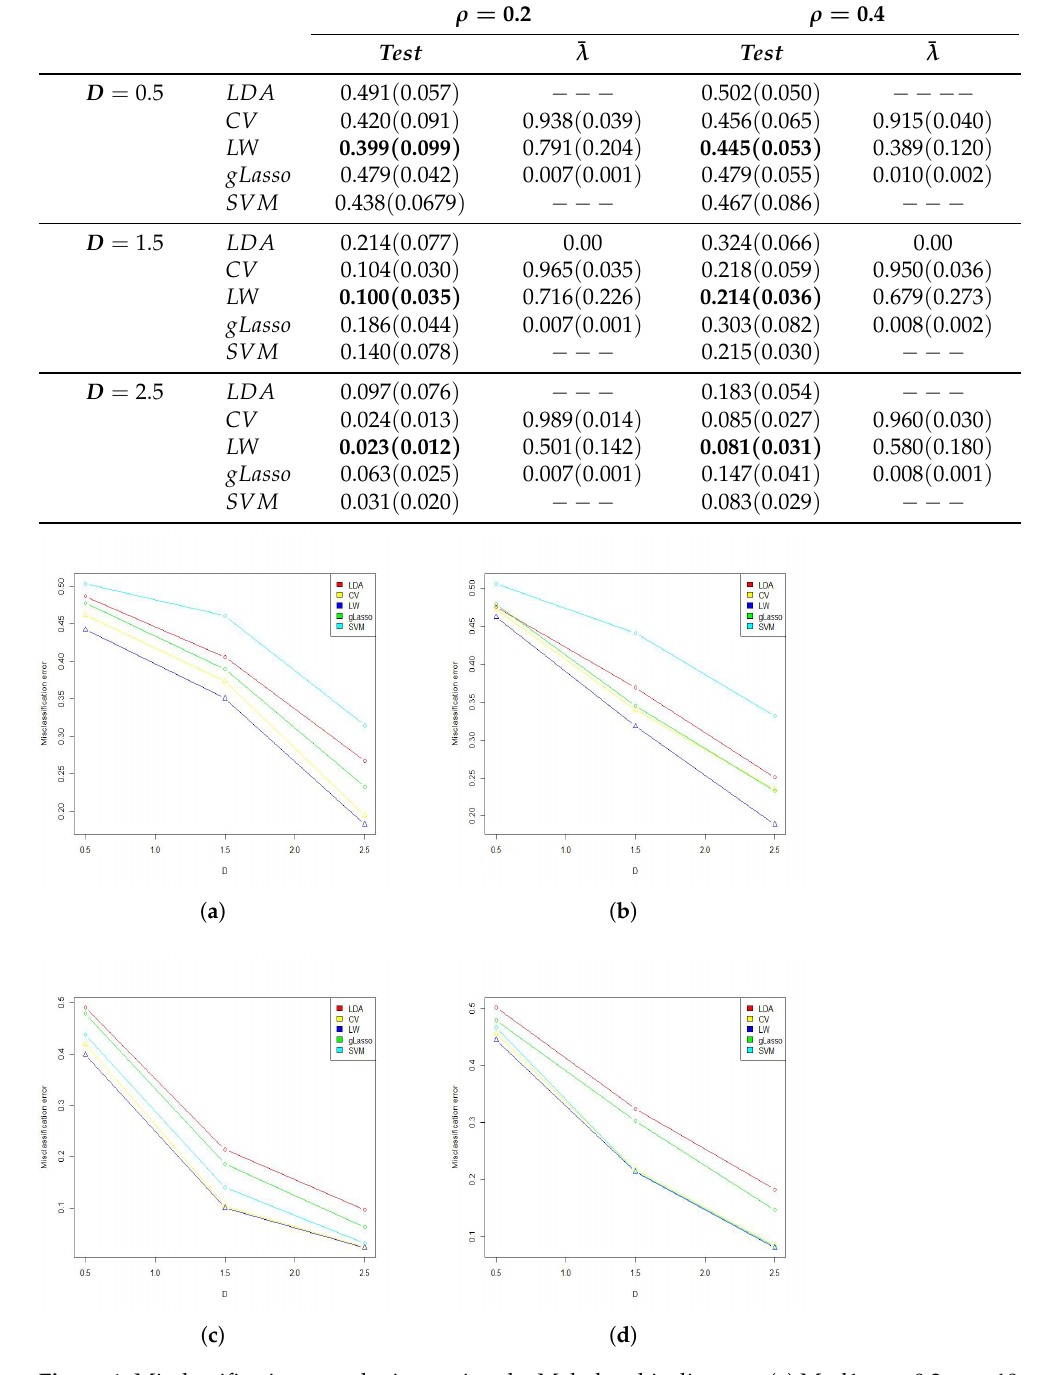
Table 2. Misclassification error and shrinkage parameter values for Mod2.